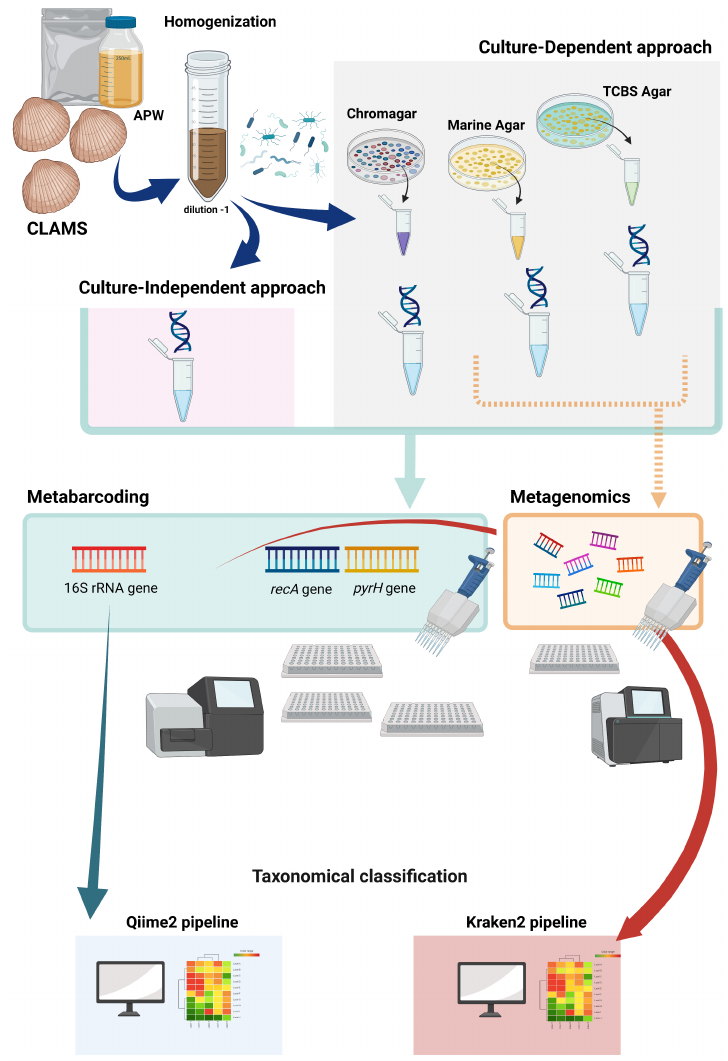
Figure 1. Flow chart of the experimental design. APW: alkaline peptone water; TCBS agar: thiosulfate- citrate-bile salts-sucrose